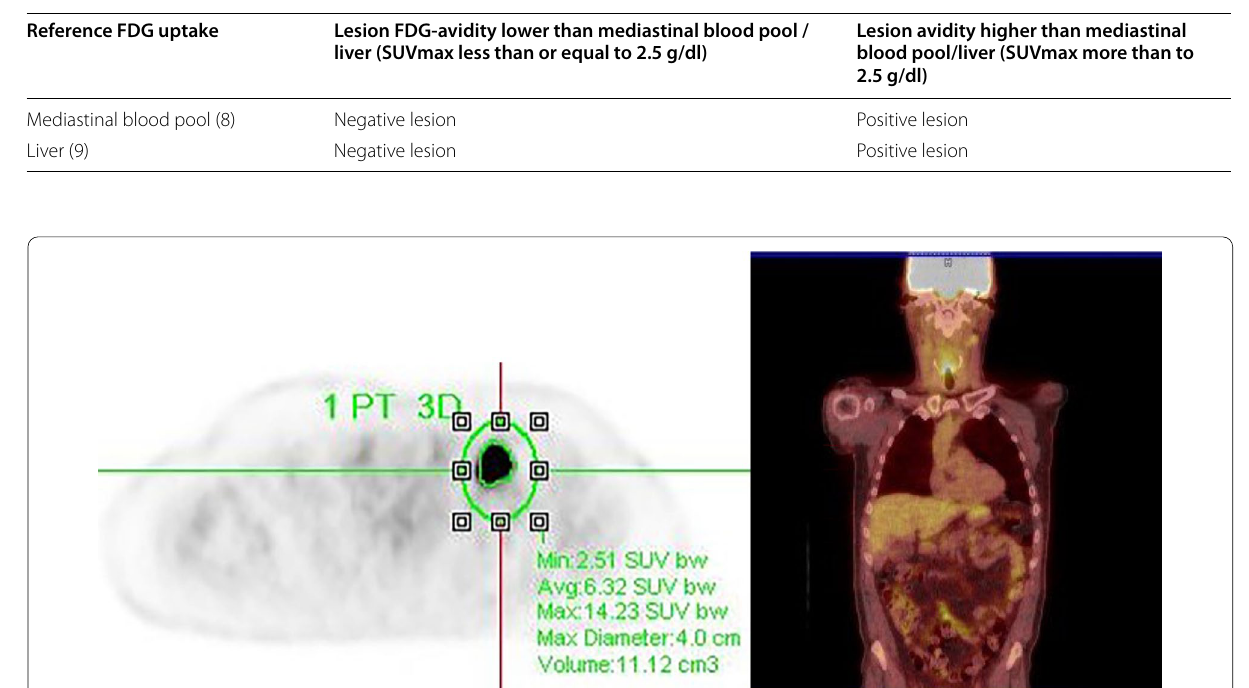
Fig. 5 Left: Measurement of a hypermetabolic lesion within the VOI. Right: Hot-body color standardization (FDG uptake: Grade 4: Brain, Grade 3: Liver, Grade 2: mediastinal blood pool and grade 1